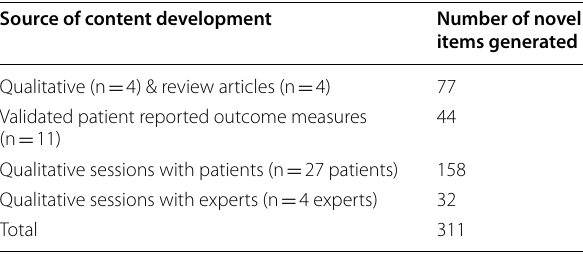
Table 2 Items generated across four sources of content development (Phase